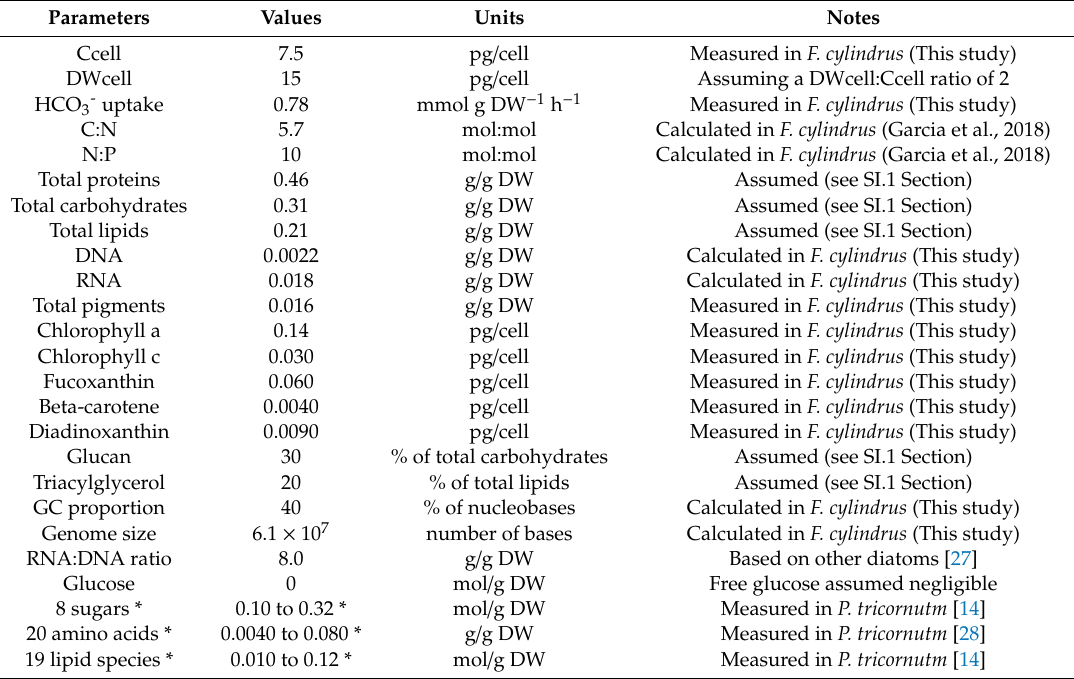
Table 1. Summary of the 69 model parameters (names, values, units, and references). There were 66 model parameters used to determine stoichiometric coe ffi cients of reactions in the objective functions and 3 other parameters that were fixed as constraints (C uptake rate, C:N, and N:P ratios). Additional discussion on the choices of all parameters is available in the Section